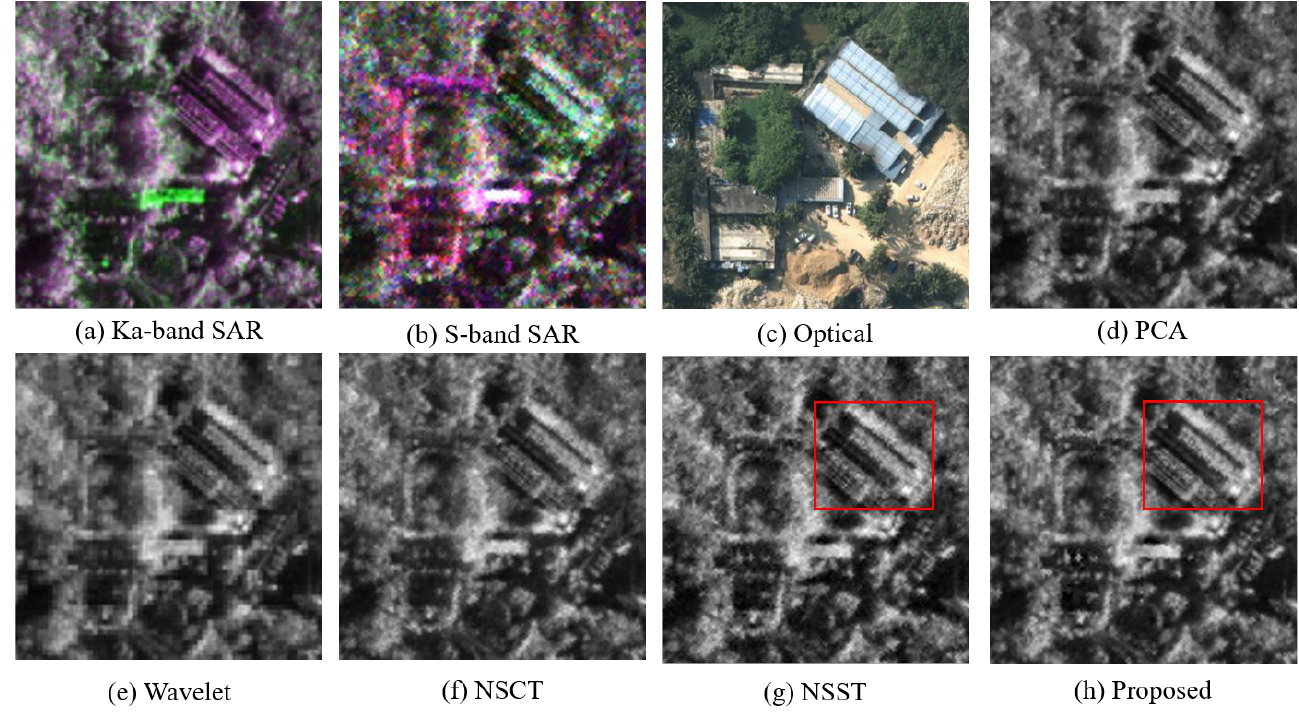
Figure 5. Representative region in scene 1 and its fusion results: ( a ) Ka-band SAR image; ( b ) S-band SAR image; ( c ) optical image; ( d ) PCA fusion; ( e ) wavelet fusion; ( f ) NSCT fusion; ( g ) NSST fusion and ( h ) proposed method fusion.